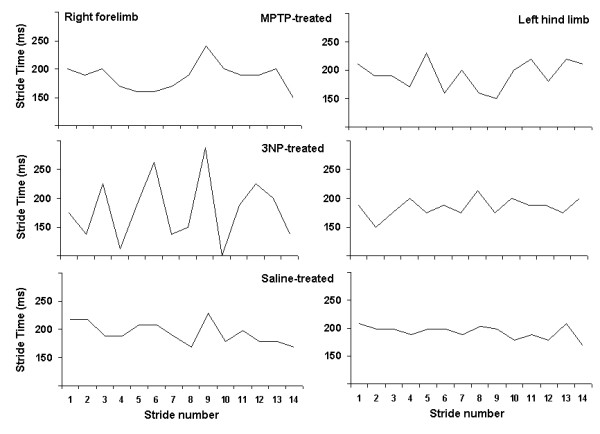
Stride time dynamics. Examples of stride time (gait cycle duration) in MPTP-treated, 3NP-treated, and saline-treated mice of forelimbs (left panels) and hind limbs (right panels). In saline-treated animals, forelimb stride variability was higher than hind limb stride variability. MPTP-treated and 3NP-treated mice exhibited significantly higher stride variability. The coefficient of variation (CV), a measure of stride-to-stride variability, was highest in the forelimbs of 3NP-treated mice.